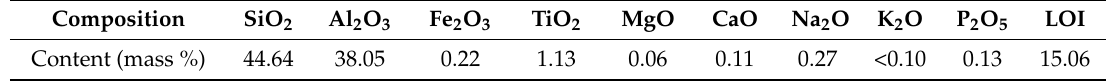
Table 1. Chemical composition of kaolinite (Kaol) obtained from Zhangjiakou. Composition SiO 2 Al 2 O 3 Fe 2 O 3 TiO 2 MgO CaO Na 2 O K 2 O P 2 O 5 LOI Content (mass %) 44.64 38.05 0.22 1.13 0.06 0.11 0.27 <0.10 0.13 15.06 LOI: loss on